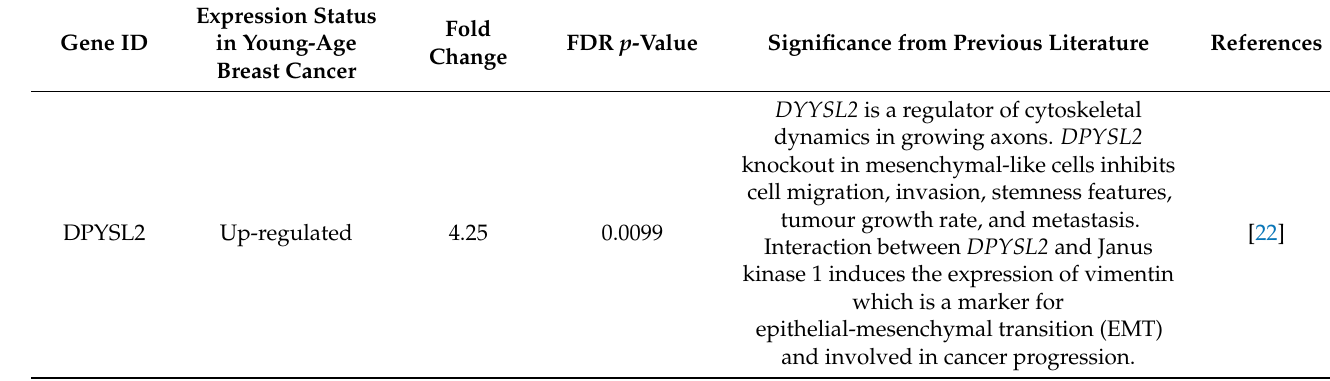
Figure 1. Heatmap illustrating the expression levels of the differentially expressed genes (DEGs) between the young and old-age breast cancer tissues ( n = 12). Hierarchical clustering of the 12 ER- positive breast cancer cases. Six samples of young age patients ≤45 years and six samples of old age patients ≥55 years. The expression levels for each differentially expressed gene are reflected by a color ranging from blue (low) to red (high). Table 3. The implication of the differentially expressed genes by young age ER-positive breast cancer in tumorigenesis and cancer progression.